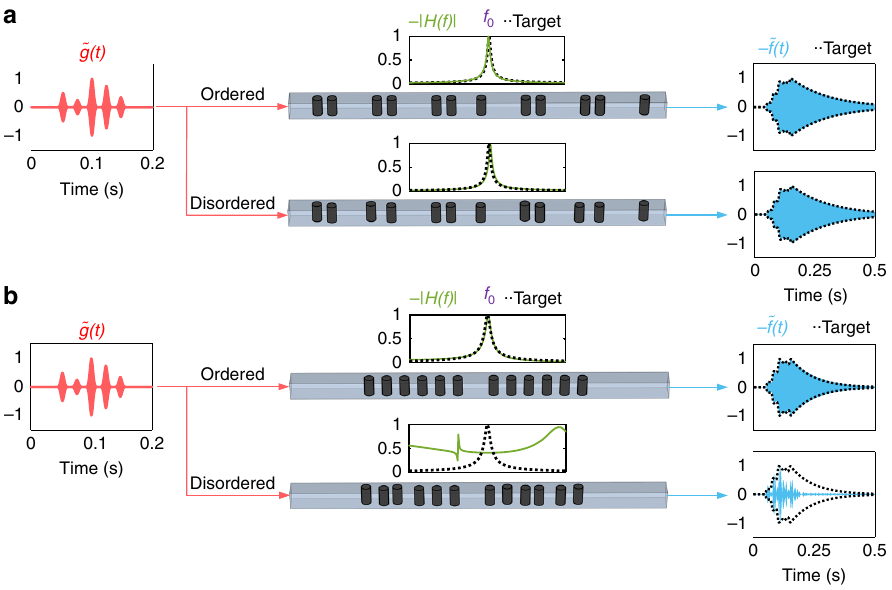
Fig. 2 Numerical demonstration of the topological differential equation. We compare a topological ( a ) and a trivial ( b ) acoustic signal processors designed such that the envelope of their output ~ f t ð Þ is the solution of the differential equation f ′ ( t ) + α f ( t ) = β g ( t ), where g ( t ) is envelope of the input signal ~ g t ð Þ modulated with carrier frequency f 0 . a An arbitrarily chosen signal envelope g ( t ) is applied to the input of the topological equation solver. The transfer function of the system H ( f ) (green line), which reproduces exactly the mathematical target de fi ned by the equation (dashed line), is not affected by the presence of disorder (bottom signal path). As a result, the envelope of the output signal f ( t ) matches exactly the solution even in the presence of disorder. b Conversely, in a topologically trivial processor, the presence of disorder-induced localized states creates spurious peaks and shifts the transfer function of the system, which makes it deviate from the targeted transfer function (dashed line). The parameters of the linear differential equation are chosen to be α = β = 2 π , and the position disorder strength is 18% of the lattice period in both